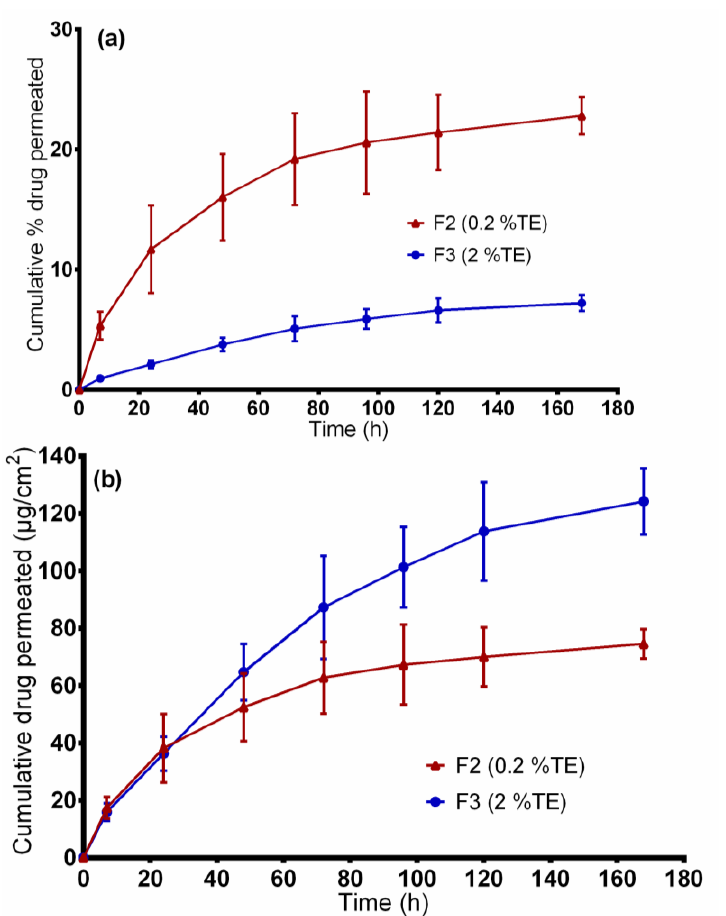
Figure 6. Ex vivo drug permeation studies. ( a ) percentage of permeated betulin and ( b ) amount of betulin permeated (µg/cm 2 ) from TE-loaded wound dressings.